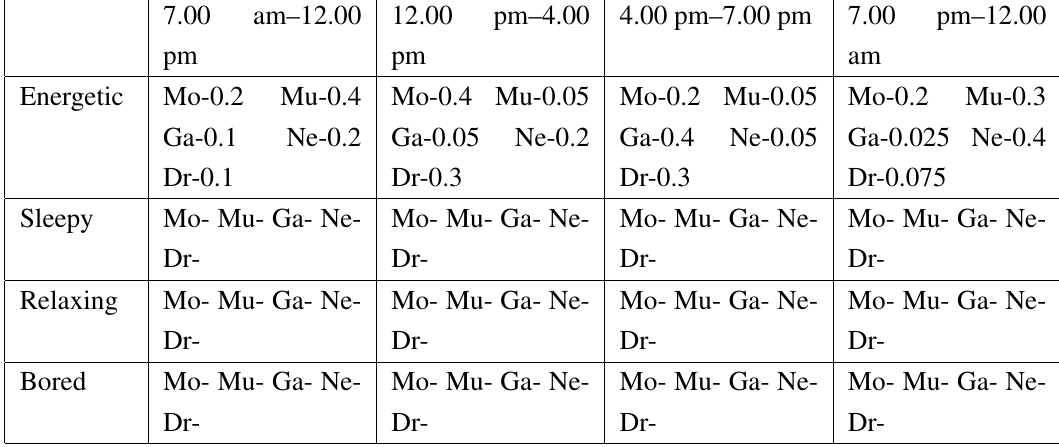
Table 2. Point distribution based on the moods and time of the day.